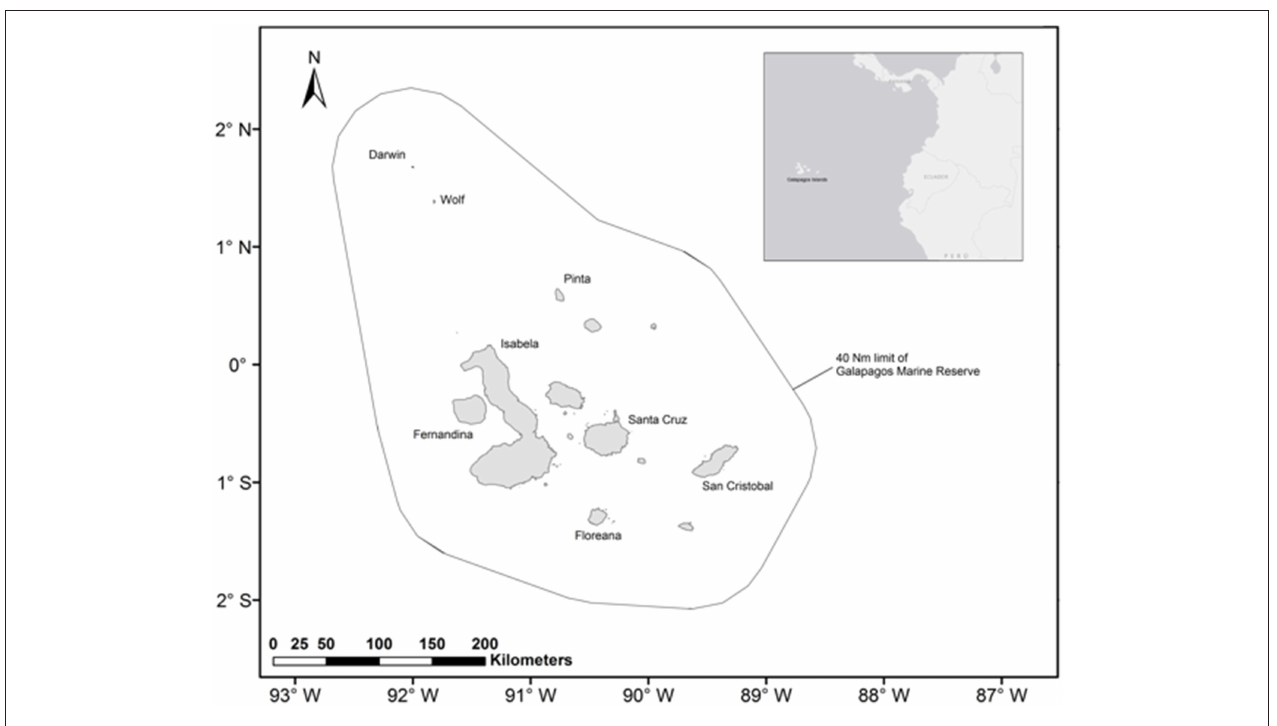
FIGURE 1 | Map of the Galapagos Islands and its marine